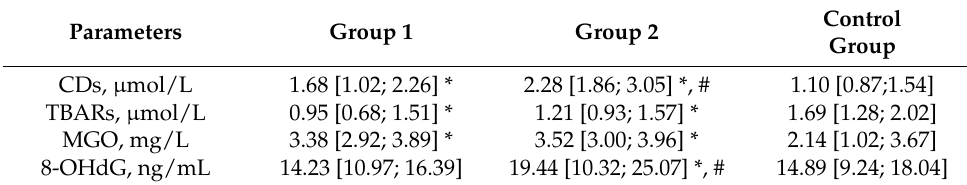
Table 4. Oxidative damage product levels in men with T1DM (Me, [Q1;